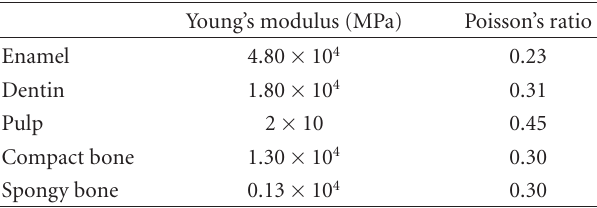
Table 2: Material properties of mandibular bone (compact bone, spongy bone) and teeth (enamel, dentin,